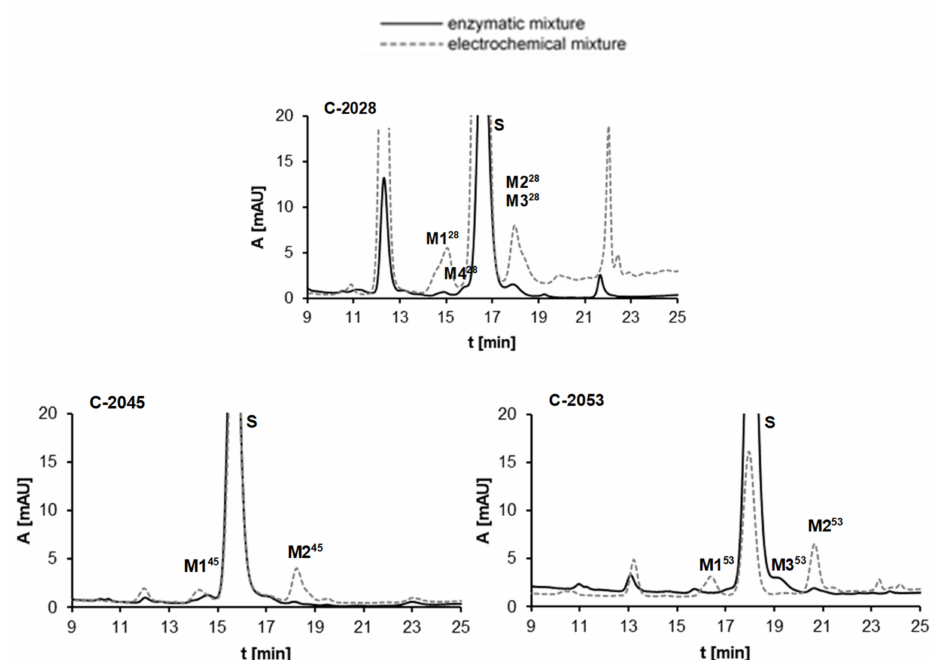
Figure 6. Comparison of HPLC analyses of the reaction mixtures after 30 min enzymatic (UT-RLMs) incubations and the electrochemical conversions of 0.05 mM C-2028, C-2045 and C-2053. Experimental conditions: enzymatic analysis—0.1 M HEPES buffer, pH 7.4, 2 mg/mL UT-RLMs, 2 mM NADPH, 2 mM MgCl 2 ; electrochemical analysis—water-methanol (1:1, v / v ) with 0.1% formic acid as electrolyte, potential range − 2.5–0 V, glassy carbon working electrode ( φ = 8